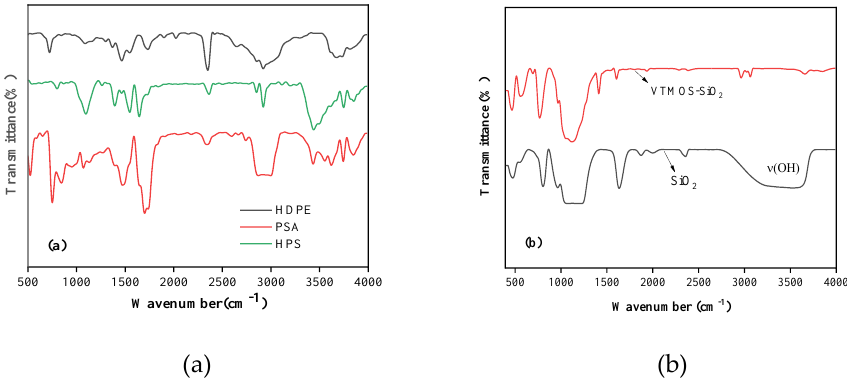
Figure 4. Fourier transform infrared (FTIR) spectra of different materials ( a ) pure high-density polyethylene (HDPE), copolymer PSA and composite HPS; ( b ) nano silicon.